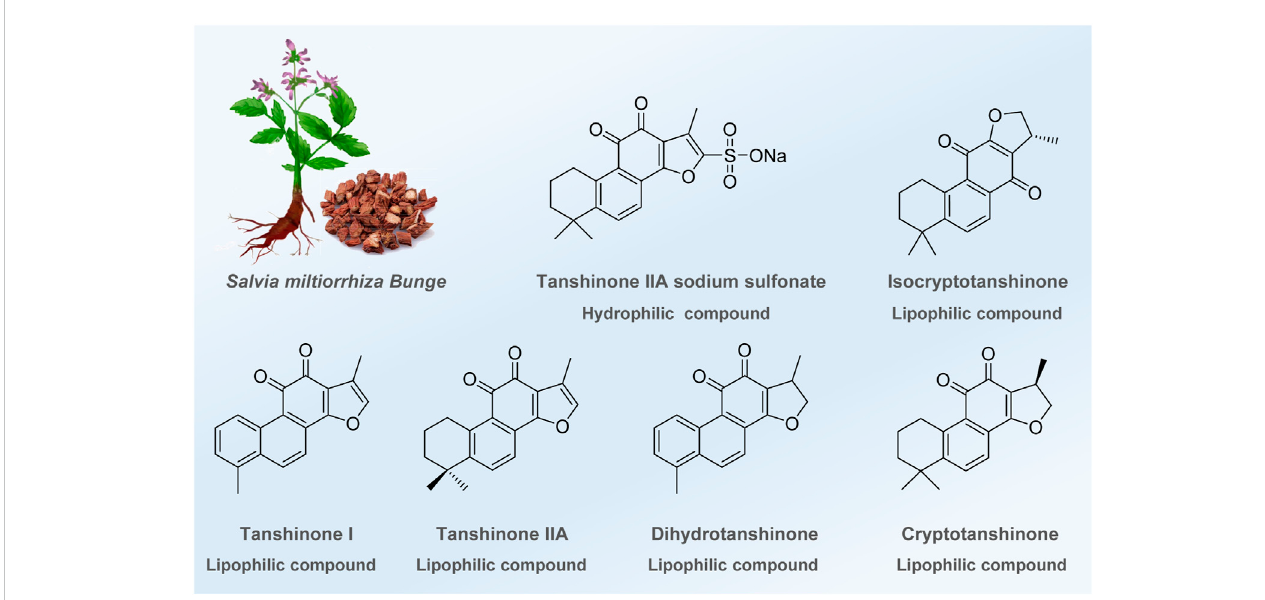
FIGURE 1 Bioactive ingredients identi fi ed or modi fi ed from Salvia miltiorrhiza in regulating